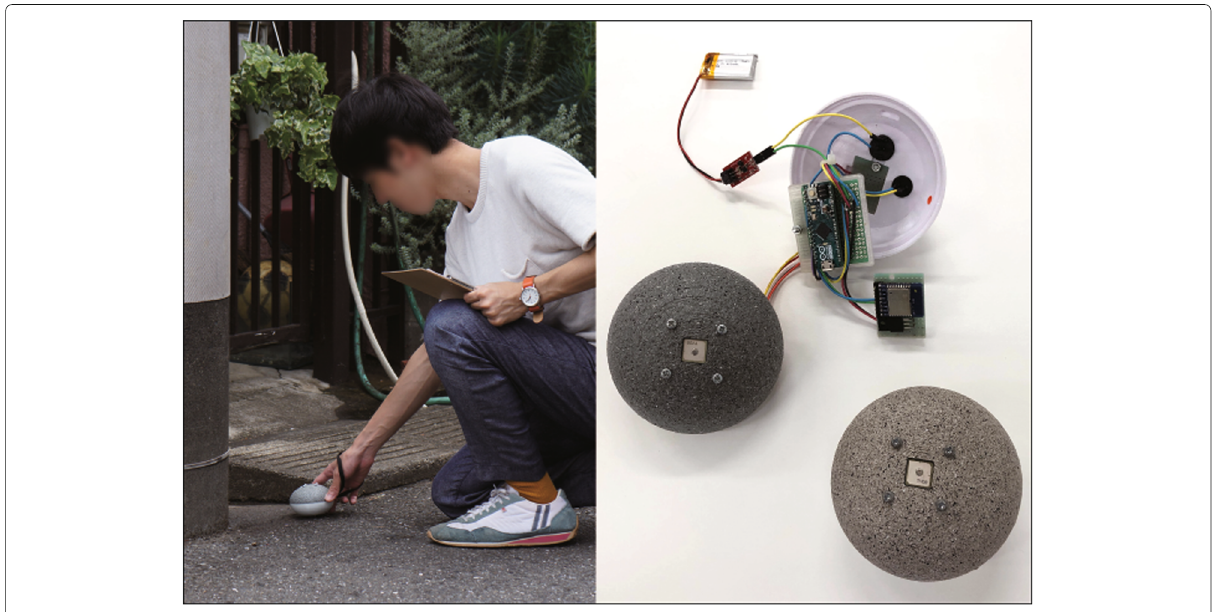
Fig. 3 Device for collecting and evaluating hazardous elements